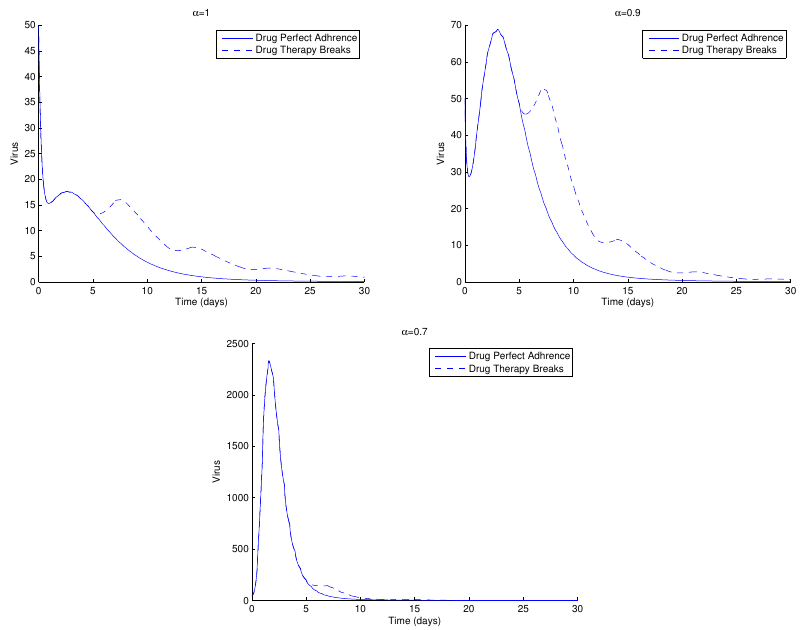
Figure 7. HIV viral load of system (1) for two different therapy strategies and α = 1 ( top left ), α = 0.9 ( top right ) and α = 0.7 ( bottom ). Parameter values and initial conditions are in the text, except R k = 4.5. For more information, see